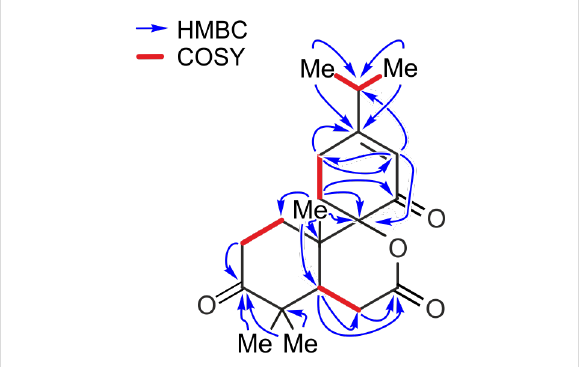
Figure 3: Diagnostic NOE interactions for decandrinin ( 1 , B97D/TZVP- optimized structure): arbitrarily the 5 R ,9 R ,10 S -enantiomer is